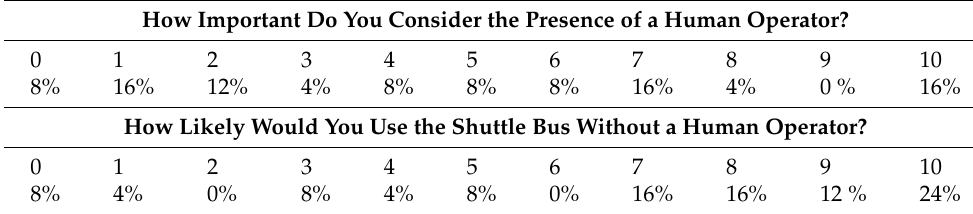
Table 1. Descriptive Statistics: Importance of Human Operator from 0 (=not at all/unlikely) to 10 (=very important/very